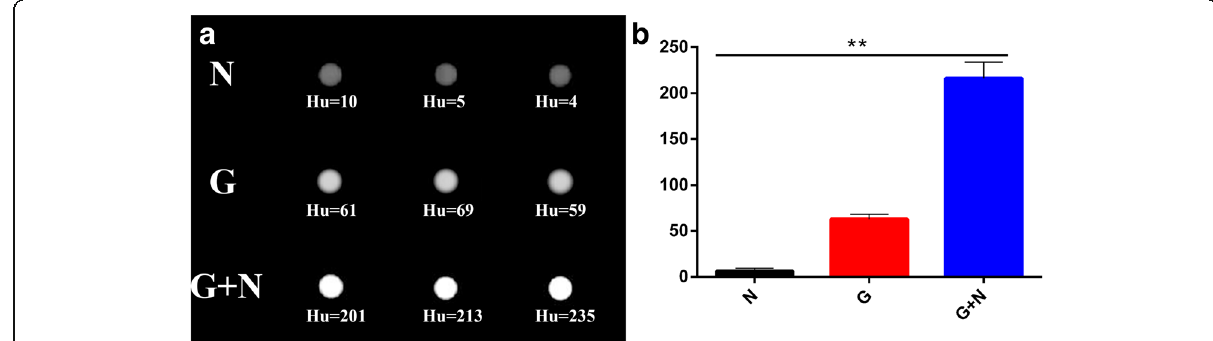
Fig. 6 a , b In vitro CT scanning of different groups. The values of the G+N group were significantly higher than those of the G and N groups. Furthermore, X-ray attenuation values of the G group were significantly higher than those of the N